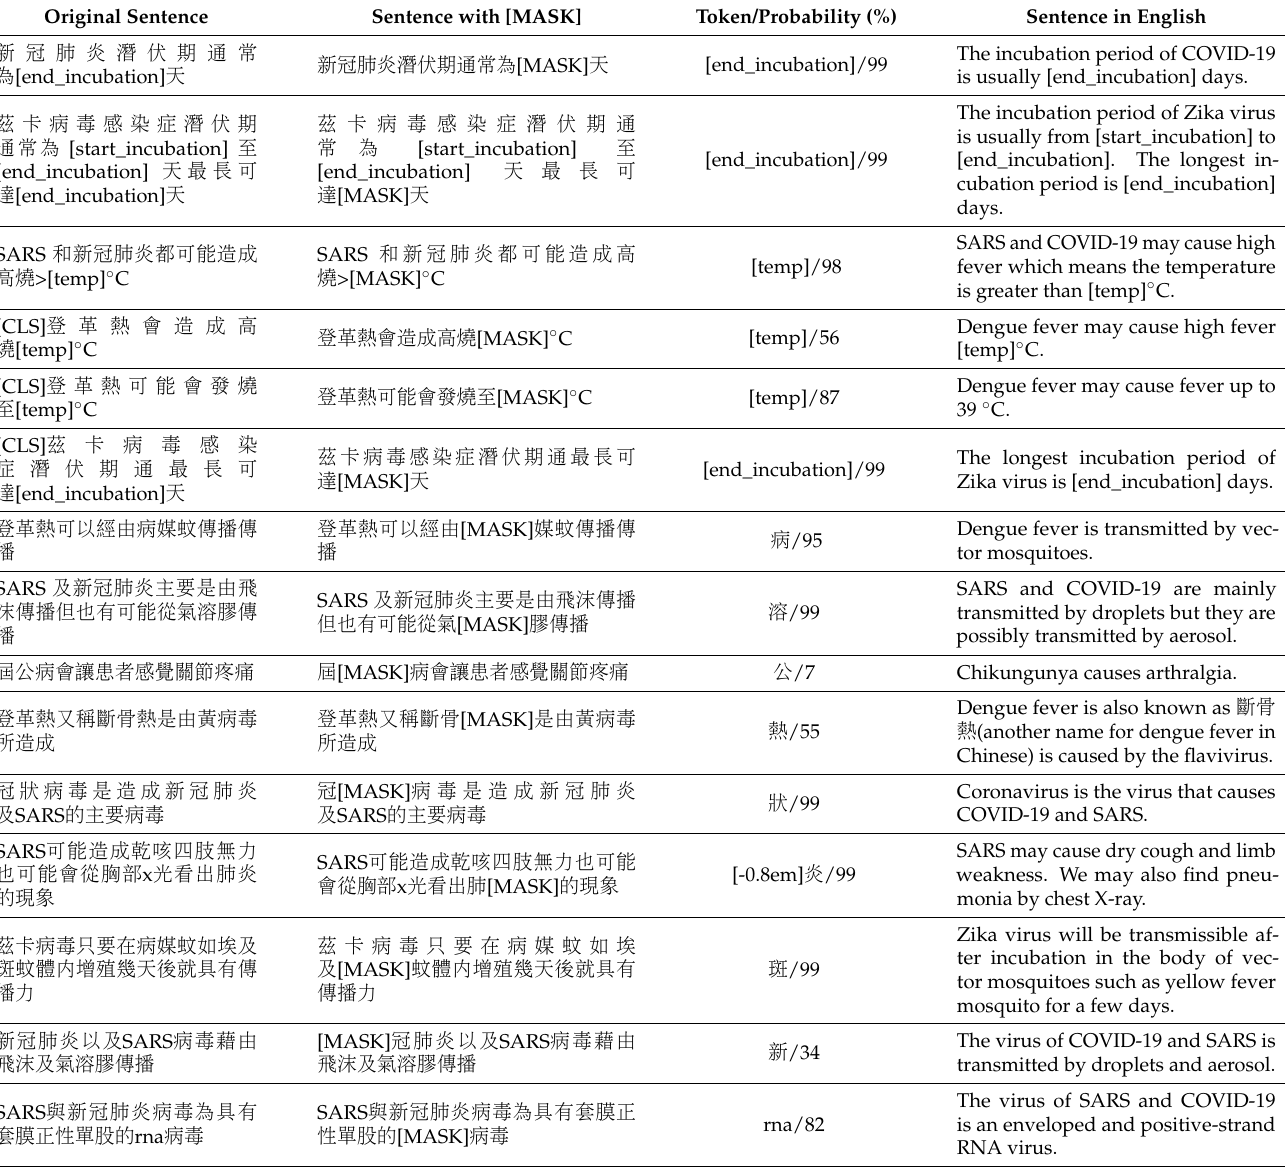
Table 6. Results of the BERT model fine-tuned with mask LM